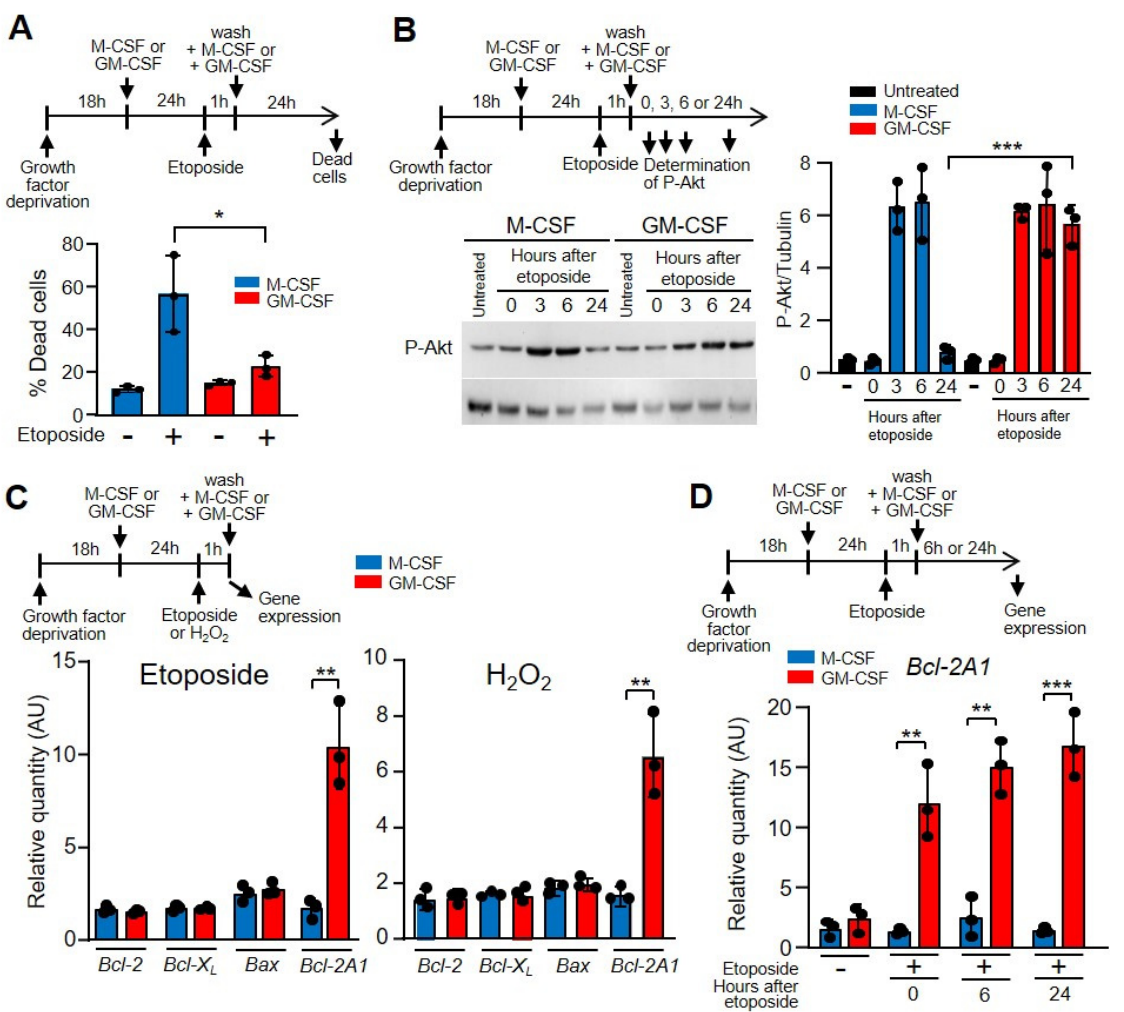
Figure 4. GM-CSF reduced the effect of etoposide on macrophage death. ( A ) The experimental design is shown at the top. Macrophages were incubated in M-CSF or GM-CSF for 24 h, then treated for 1 h with etoposide, washed and incubated again with M-CSF or GM-CSF for 24 h, after which dead cells (necrotic and apoptotic) were quantified by FACS analysis ( n = 3). ( B ) The experimental design is shown at the top. The expression of phosphorylated Akt ( P Akt) was measured by western immunoblotting using tubulin as the control (right panel). Left panel, quantification by densitometry of the western immunoblotting ( n = 3). ( C ) The experimental design is shown at the top. Macrophages were cultured in the presence of M-CSF or GM-CSF for 24 h, then incubated with etoposide or H 2 O 2 for 1 h, after which gene expression was analyzed by real-time PCR ( n = 3). ( D ) The experimental design is shown at the top. Macrophages were incubated in M-CSF or GM-CSF for 24 h, then treated for 1 h with etoposide, washed and incubated again with M-CSF or GM-CSF for 6 or 24 h, after which gene expression was analyzed ( n = 3). Each experiment was performed in triplicate, and the results are shown as the mean ± SD. * p < 0.05, ** p < 0.01 and *** p < 0.001 in relation to the corresponding treatments with M-CSF or GM-CSF, when all the independent experiments had been compared. Data were analyzed using Student’s t -test, with the exception of ( A , D ), which was performed using ANOVA test.